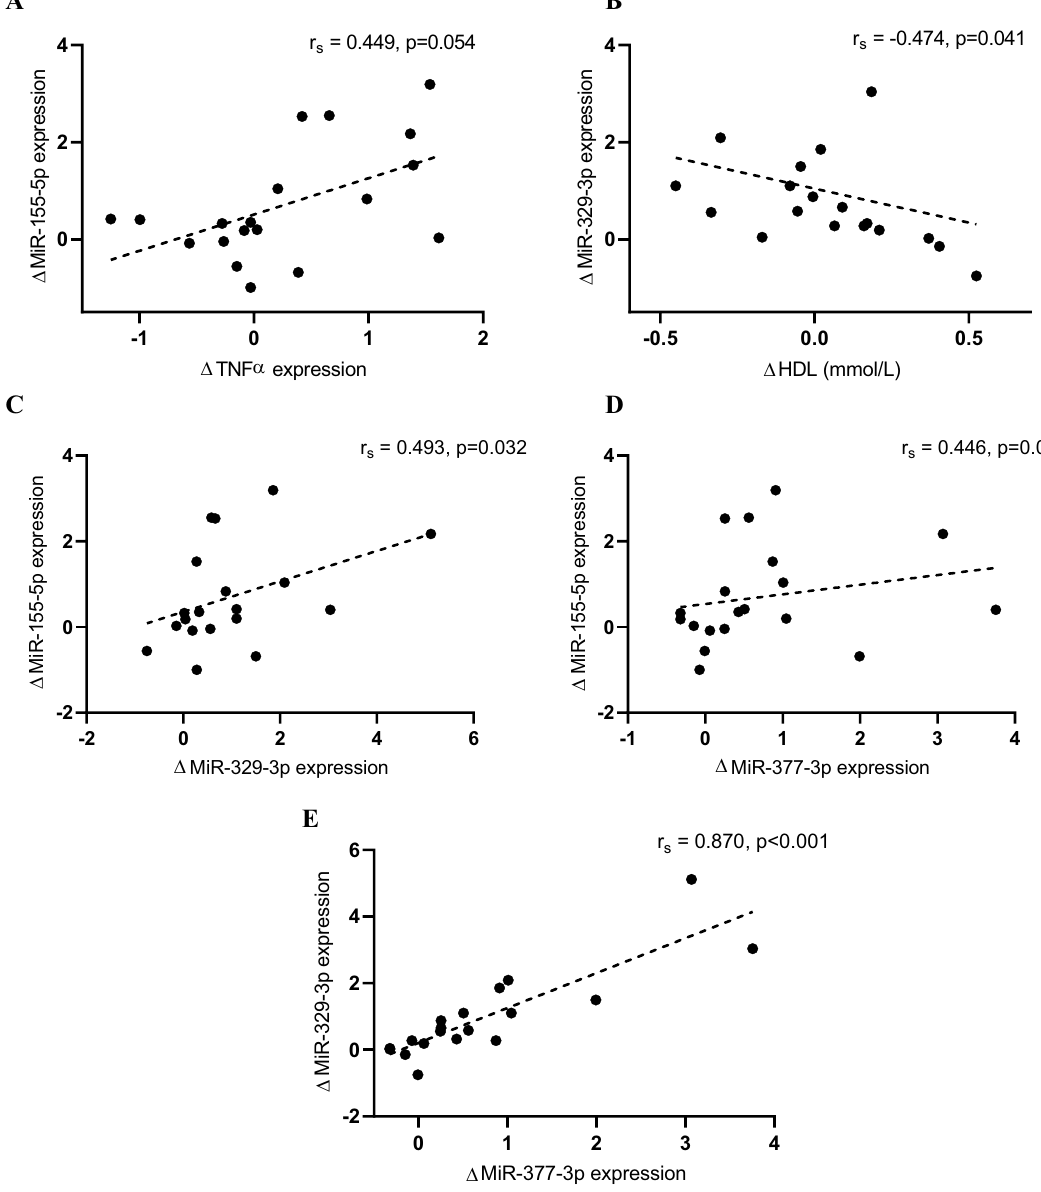
Figure 2. Spearman’s correlation analysis of the post-training change from baseline (Δ) in miR-155-5p expression and changes in TNFα gene expression in GSAT ( A ), miR-329-3p expression in GSAT and high- density lipoprotein (HDL) levels ( B ), miR-155-5p and miR-329-3p expression in GSAT ( C ), miR-155-5p and miR-377-3p expression in GSAT ( D ) and miR-329-3p and miR-377-3p expression in GSAT ( E ). Each point represents a participant. Linear regression lines used for descriptive purposes